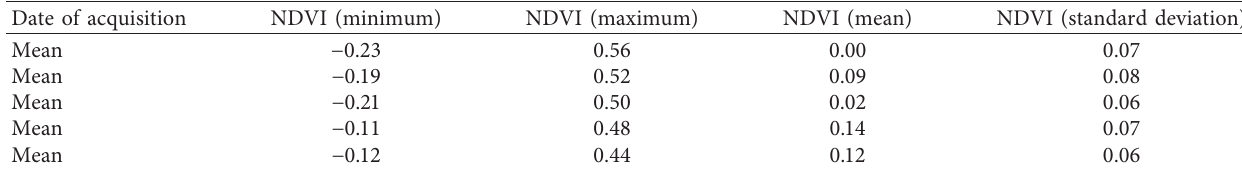
Table 5: Temporal variations in the distribution of NDVI for whole Raipur City